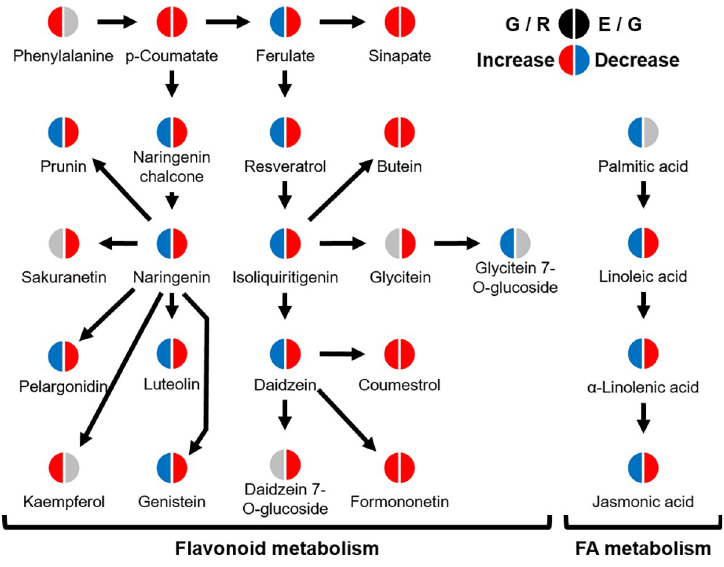
Fig 4. Comparative analysis of metabolic pathways among raw seed, germination, and elicitation samples. The estimated effect of germination and elicitation on flavonoid and fatty acid metabolic pathways. Details of these metabolites are given in S2 Table and S1